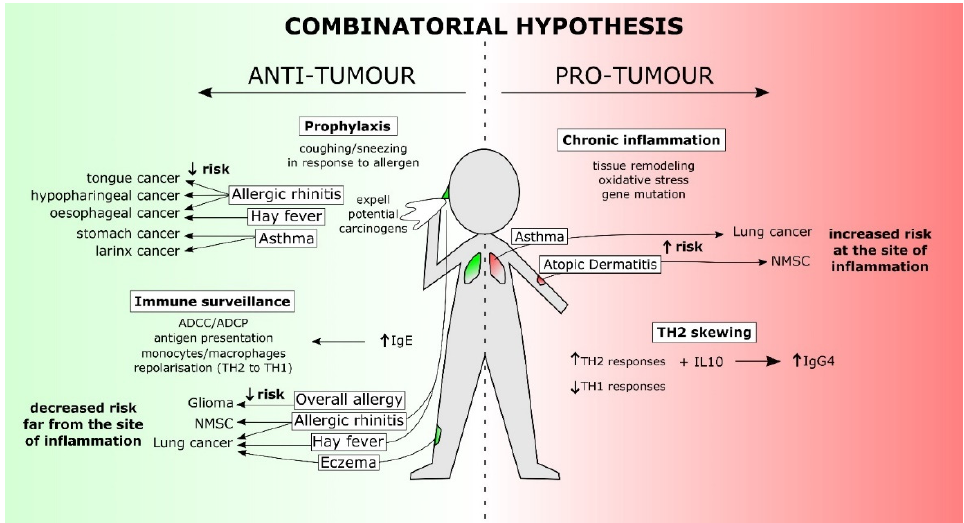
Figure 2. The combinatorial hypothesis accounts for the complex relationship between allergic diseases and an individual’s risk of developing a specific cancer. The combinatorial hypothesis takes into account different immunological conditions created within the context of specific local and systemic allergic diseases, which influence the risk for the development of different cancer types. This risk may be derived from four hypotheses thus far proposed to explain the nature of the relationship between IgE, allergy/atopy, and cancer. These hypotheses can in turn be divided into those that propose an anti-tumour outcome and those proposing a pro-tumour outcome. For anti-tumour outcomes, the prophylaxis hypothesis assumes that symptoms of allergy, such as coughing and sneezing, act to expel potential carcinogens before they can trigger tissue damage and inflammation. Reported decreased risk of cancers of the upper gastrointestinal tract associated with respiratory allergy is an example in support of this hypothesis. The second anti-tumour hypothesis is the immunosurveillance hypothesis, which states that allergy is reflective of a hyperactive immune system, which in turn is better equipped to defend against tumours. Supporting this, several cancers distant to the site of allergic inflammation are protected against by presence of allergy or high serum IgE. The pro-tumour hypotheses are the chronic inflammation hypothesis and the Th2 skewing hypothesis. The chronic inflammation hypothesis presumes that inflammation, driven by allergy, drives mutation of regulatory growth and tumour-suppressor genes, can increase cancer risk at sites of allergic challenge. This hypothesis is supported by increased lung cancer risk associated with asthma and increased non-melanoma skin cancer risk associated with atopic dermatitis. The Th2 skewing hypothesis, presumes atopy and chronic exposure to allergen challenge may drive inappropriate skewing towards alternatively activated Th2-based immune response over potentially anti-tumour Th1 or away from the typical Th2 (IgE-driven) responses, leading to an increased cancer risk at sites affected by